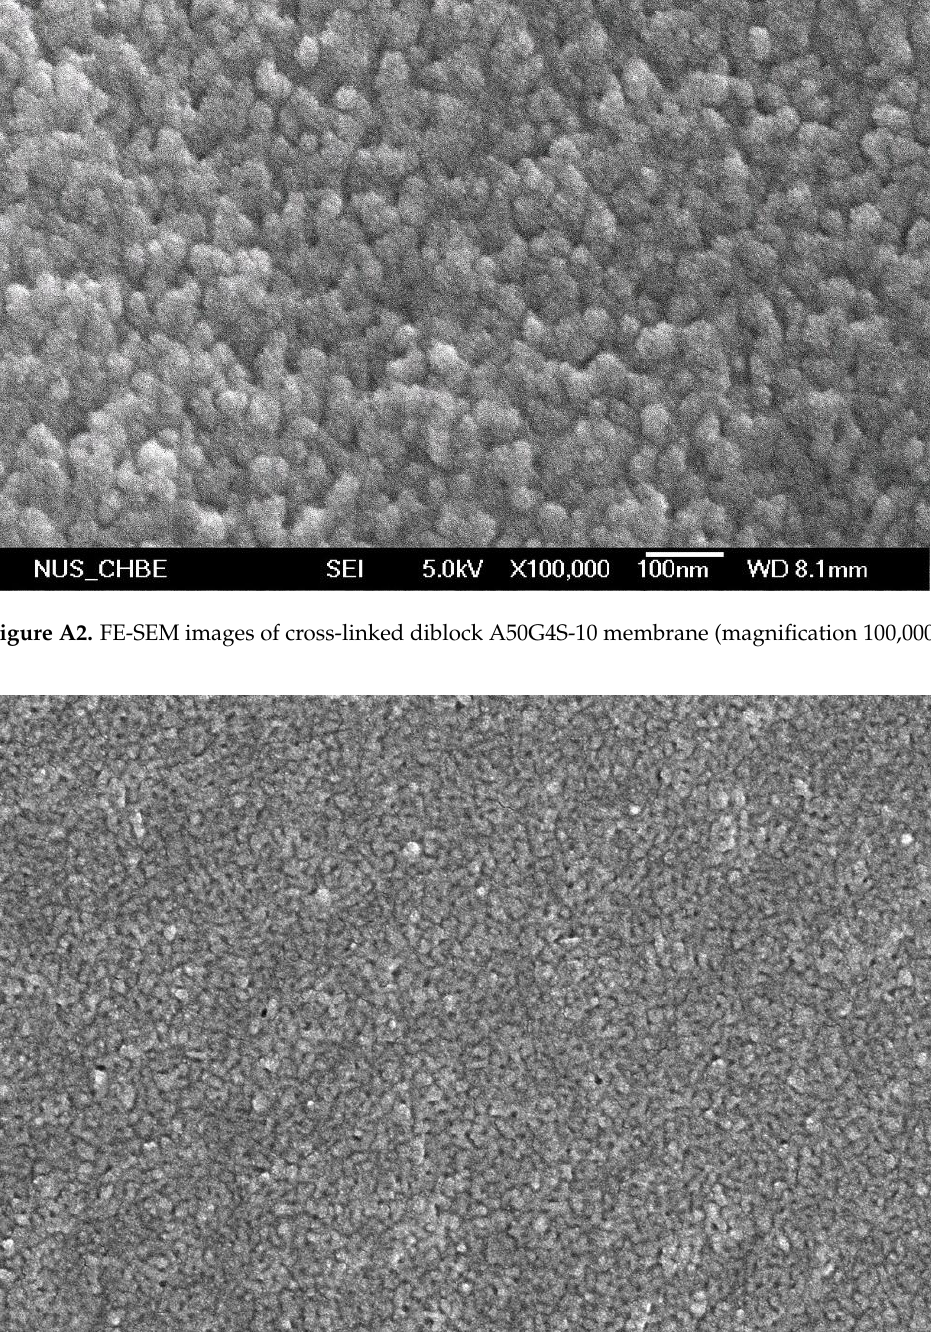
Figure A3. FE-SEM images of cross-linked diblock A100G4S-10 membrane (magnification 50,000×).